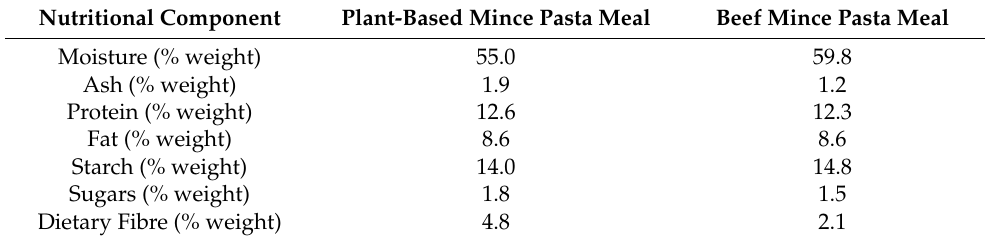
Table 1. Nutritional composition of the plant based and beef pasta meals. Nutritional